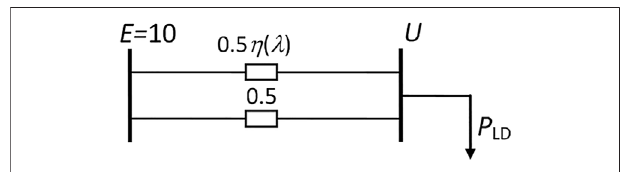
FIGURE1 | Calculation principle ofthe breaking voltage ofthe branch of a simple DC